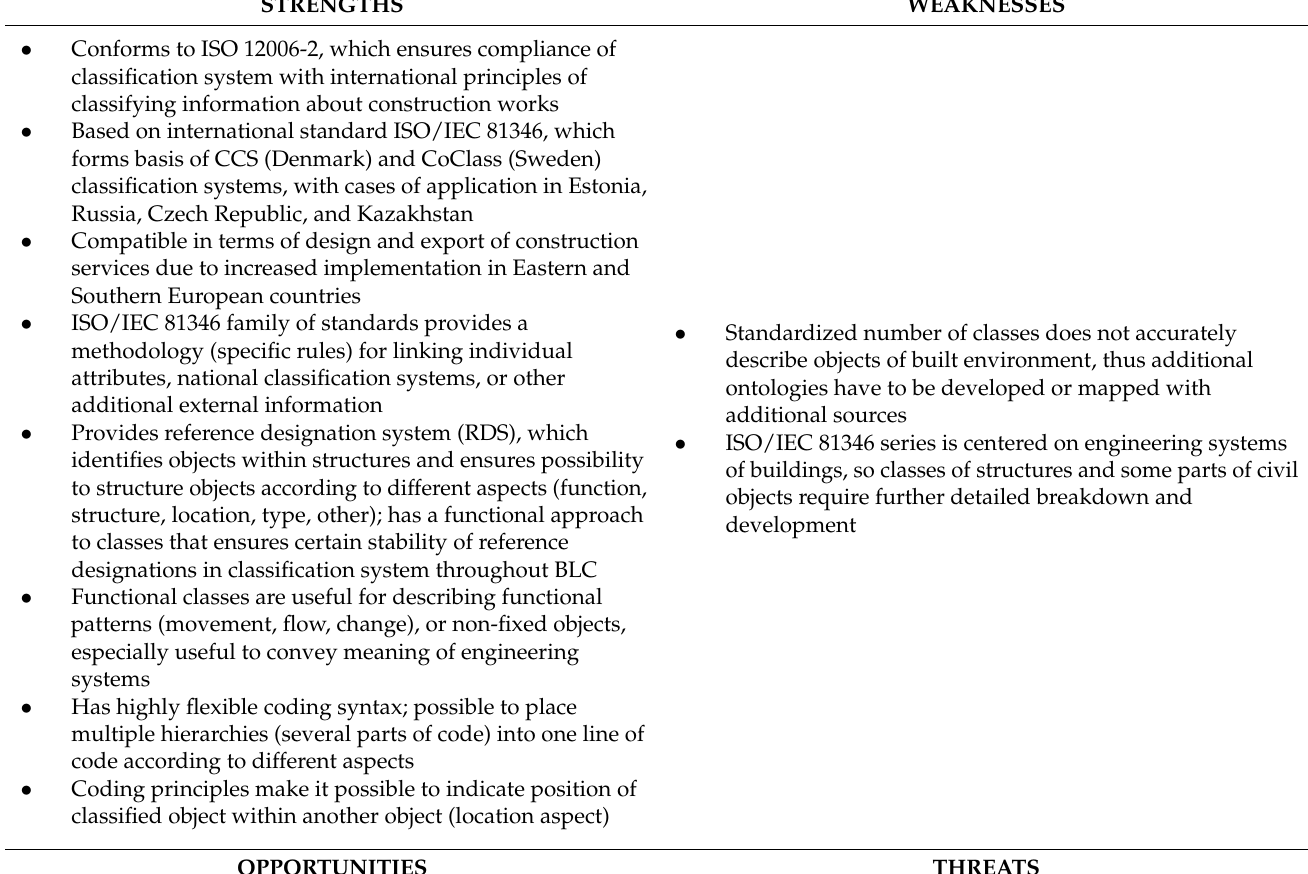
Table 12. SWOT analysis of CCI as an NCICS